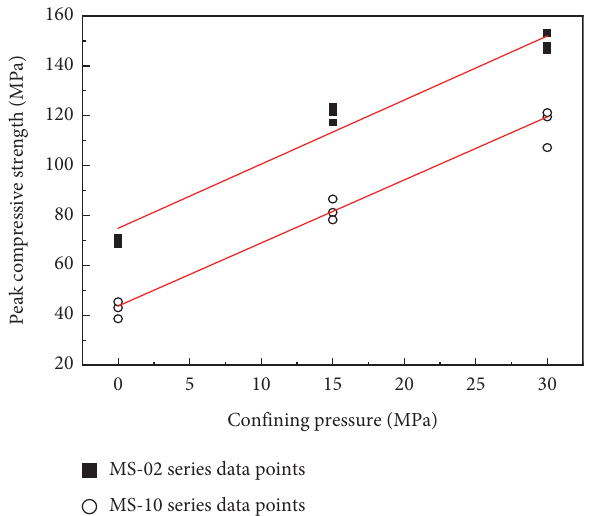
Figure 6: Peak strength versus confining pressure curve for the mudstone specimen.